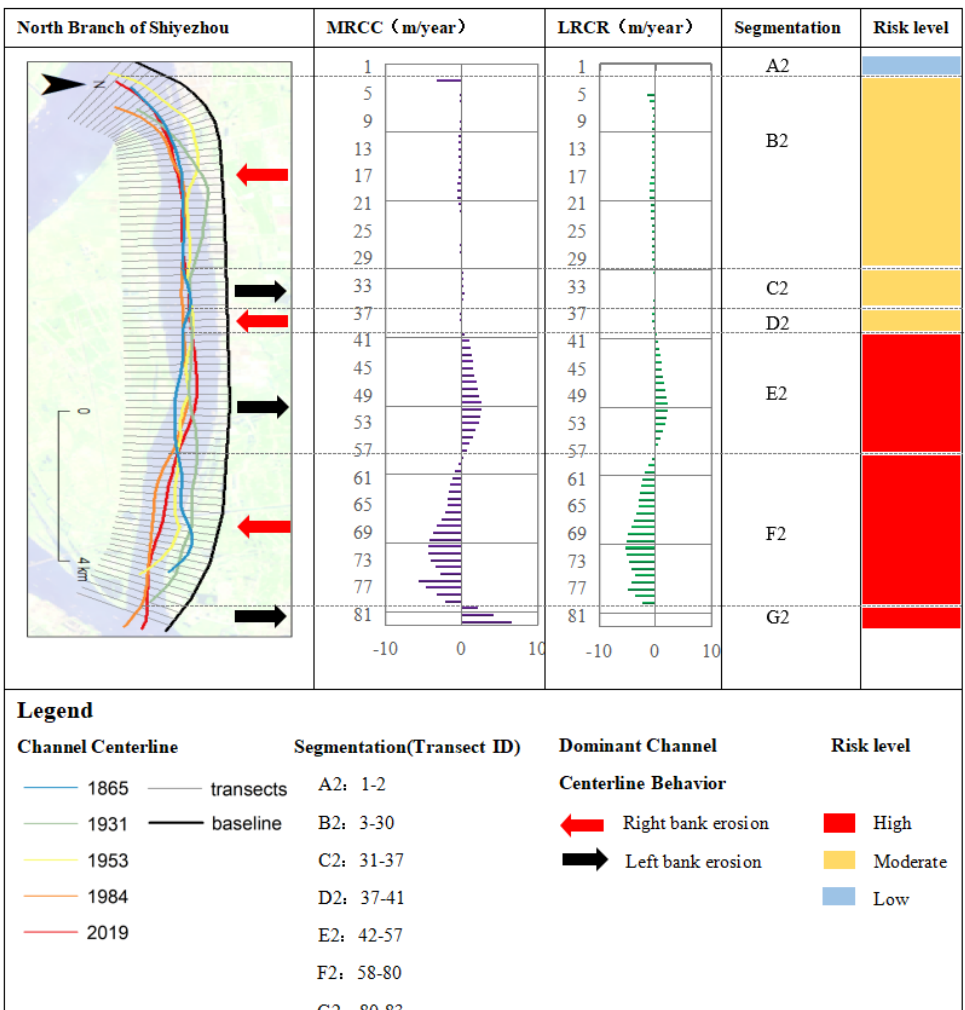
Figure 6. The Migration Rate of Channel Centerline, Linear Regression Change Rate, and erosion risk identification on North Branch of Shiyezhou. As shown in Figure 7, the maximum MRCC value of South Branch of Shiyezhou dur- ing 1868–2019 was 11.54 m/y, with an average of 5.7 m/y, and the maximum LRCR value was 12.63 m/y, with an average of 5.93 m/y. The number of left shifts of South Branch of Shiyezhou section is 3, and the number of right shifts is 63. Combining the direction and velocity of cross-section movement to identify the bank erosion risk, Yizheng Curve can be divided into four sections. Section A3 contains sections 1–5, and the erosion risk level is moderate on the right bank. Section B3 contains sections 6–8, and the erosion risk level is moderate on the left bank. Section C3 contains sections 9–15, and the erosion risk level is moderate on the right bank. Section D3 contains sections 16–67, and the erosion risk level is high on the right bank.